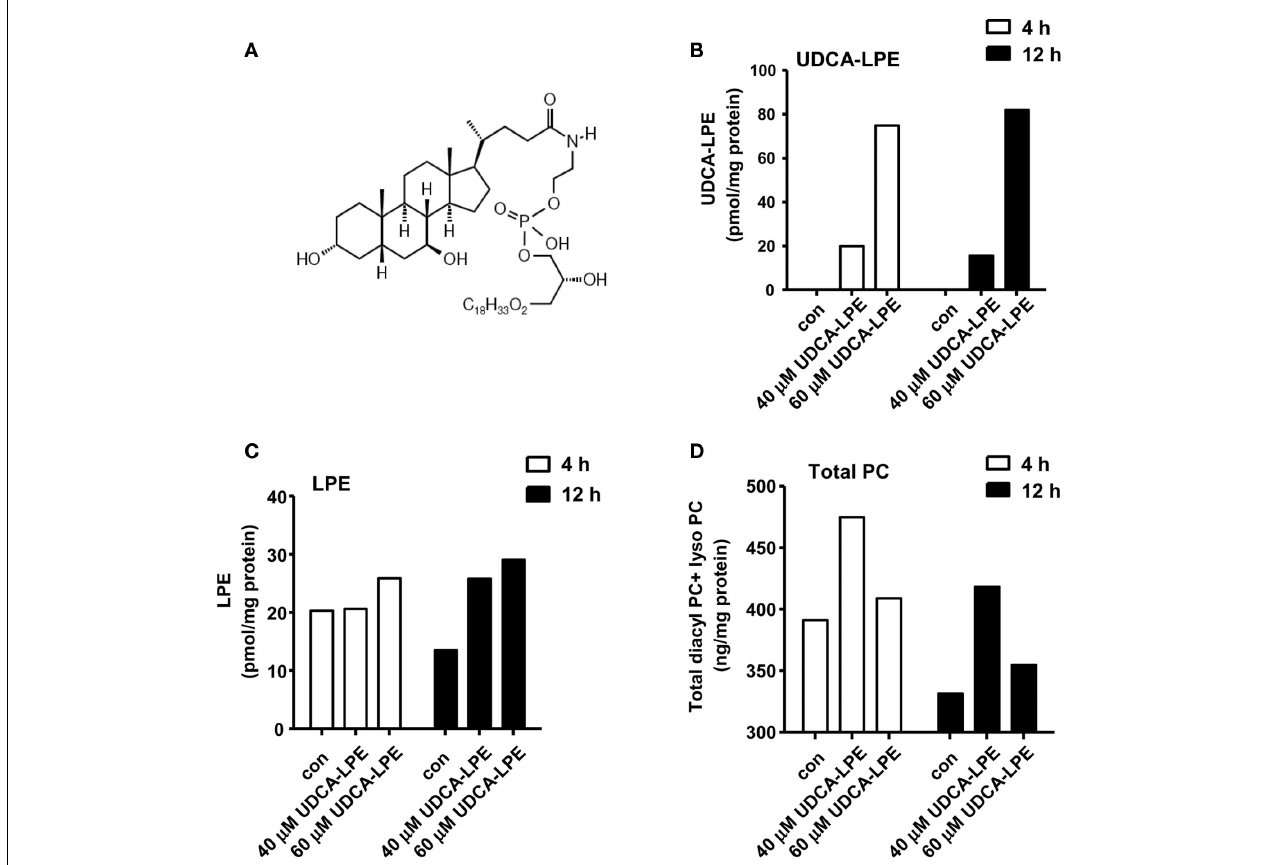
after 12h treatment indicating that UDCA-LPE hydrolysis occurred at 12h but not at 4h. (D) Total PC (diacyl PC and lyso PC) concentrations were increased mouse hepatocytes treated with 50 μ M UDCA-LPE for 4 and 20h. “Con” represents control hepatocytes treated with ethanol used as a vehicle. Data are mean ± SD, N = 4; * p < 0.05 versus